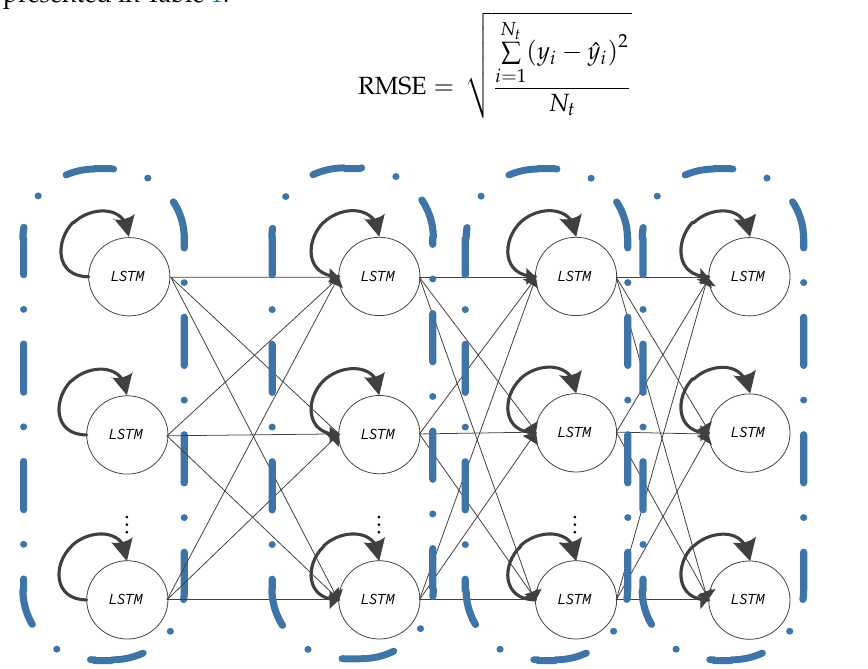
Figure 2. The proposed LSTM network structure.